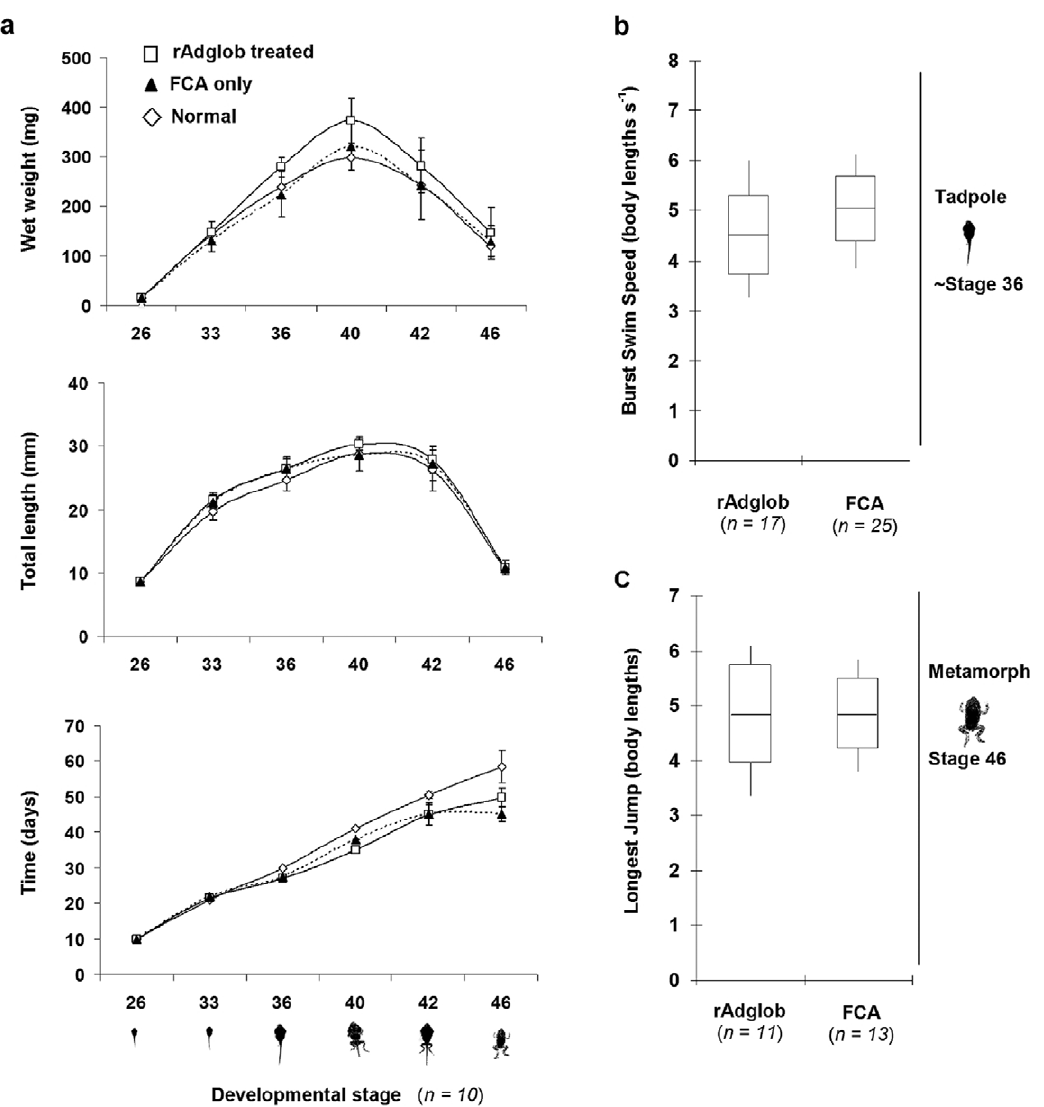
Figure 3. Physical measures of B.marinus development across metamorphosis unchanged by recombinant adult globin injection. a: Wet weights (mg), lengths (mm) and speed of development (days) for animals at six different developmental stages injected with rAdglob ( % ) or FCA control ( m , dotted line), as well as normal uninjected animals ( e ) were recorded. n=10 animals for each stage and error bars show standard deviation. b: Swimming performance of rAdglob treated and FCA control tadpoles at approximately stage 36 (or 10 days post injection) is shown. Burst swim speed represents the absolute swim speed normalised to body length, and the full data range (vertical line), standard deviation (box) and mean (horizontal line) are indicated. c: Jumping performance of rAdglob treated and FCA control amimals at stage 46 is shown. Longest jump distance was normalised to body lengths.